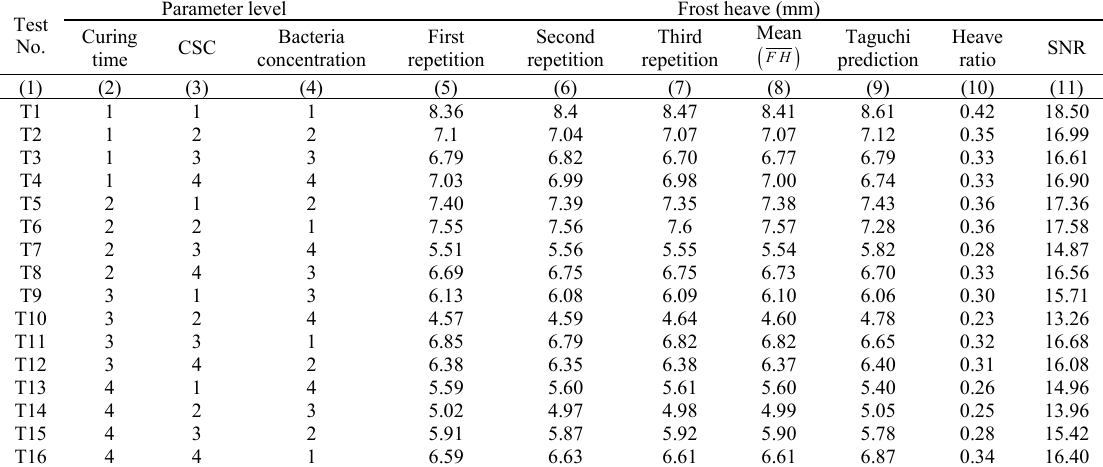
Table 4 : Frost heave test results and Taguchi predictions of MICP treated soil samples